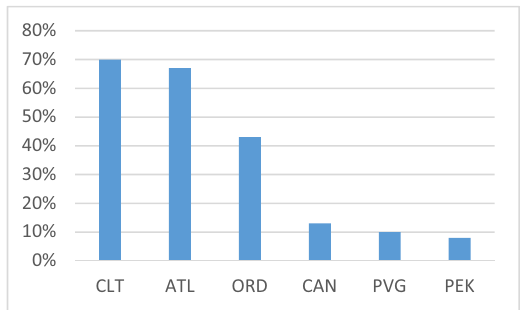
Figure 1: Comparison of transfer rates of major hub airports between China and the United States.